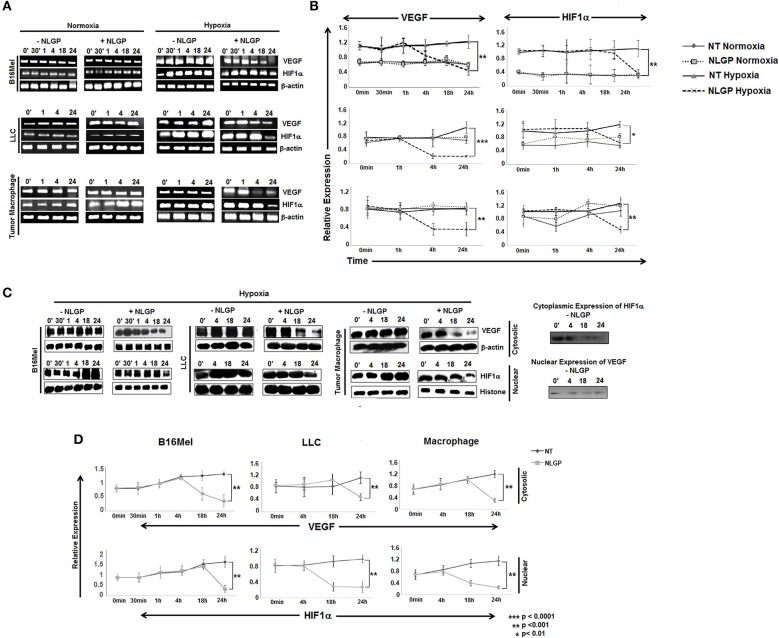
NLGP modulates HIF1α to restrain VEGF secretion in hypoxia. (A) B16Mel, LLC, and macrophages were treated w/wo NLGP and subjected to either hypoxia or kept in normoxia for different time periods. (A1) Representative data from n = 6 are shown, exhibiting mRNA for vegf and hif1α gene were studied by RT-PCR. β-actin was kept as a loading control. (B) A line graph showing different time points (0 min, 30 min, 1 h, 4 h, 18 h, and 24 h) represents the mean ± SD of relative expression of vegf and hif1α genes. p-value significance of hypoxia exposed sample are shown in all graphs, no significant change was observed in normoxic samples. (C) Western blotting was performed to check the protein level expression of VEGF and HIF1α in hypoxia for both untreated and NLGP treated cells at various time points. In the upper panel, cytosolic expression of VEGF is shown for various time points, β-actin was kept as loading control. Lower panel represents the nuclear expression of HIF1α keeping histone H3 as loading control. Basal level of cytosolic expression of HIF1α and nuclear VEGF expression in controlled condition is shown alongside the panel. (D) A line graph (n = 6) represents the mean ± SD of cytosolic VEGF and nuclear HIF1α expression w/wo NLGP treatment in hypoxia. p-values showing significance of difference are indicated in the figure.